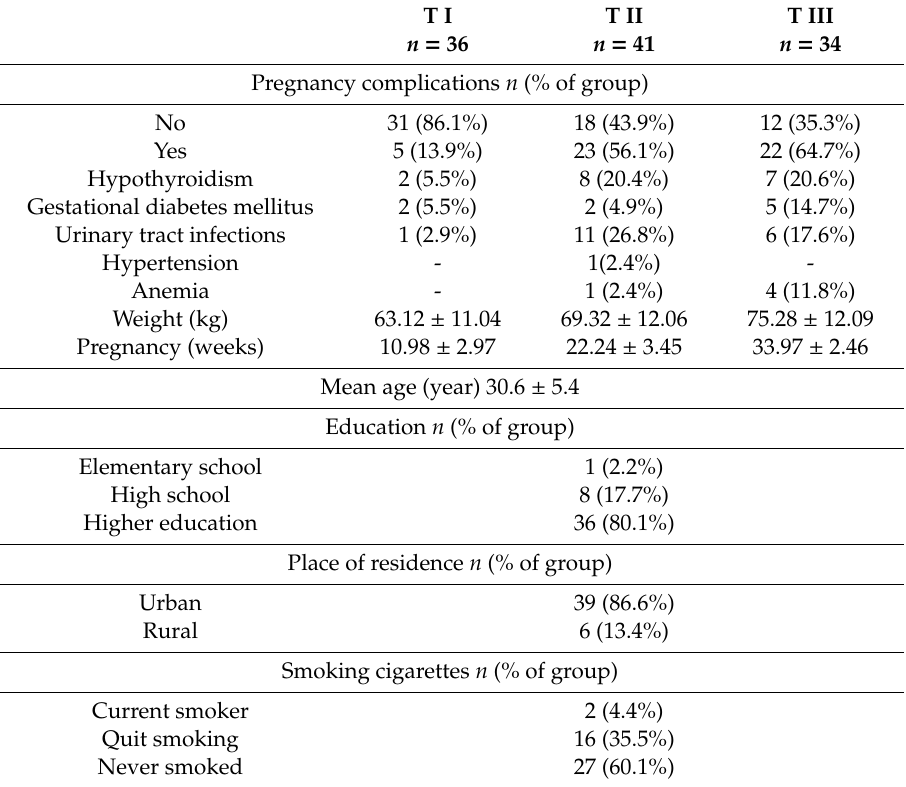
Table 1. Baseline characteristics of pregnant